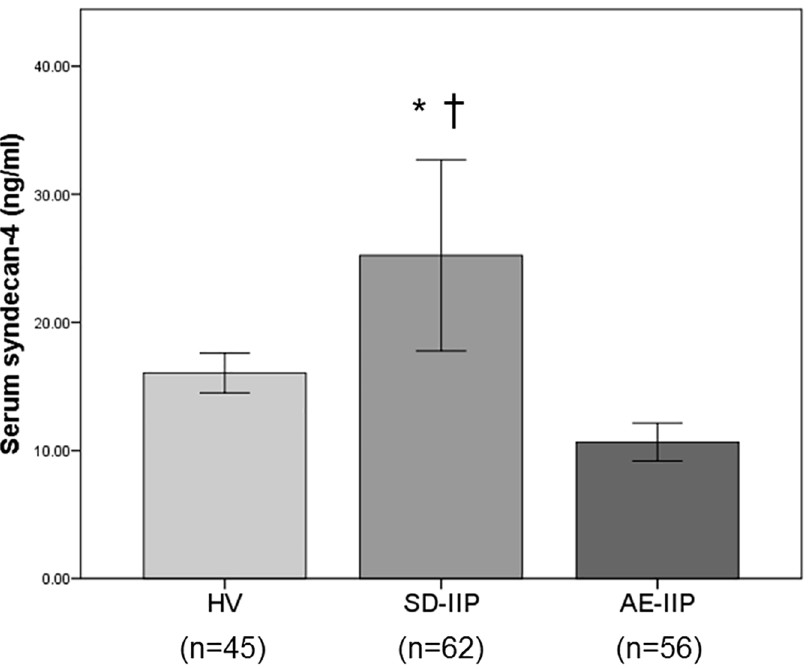
Fig 1. Comparison of serum syndecan-4 levels in healthy volunteers and in patients with SD-IIP and AE-IIP. Serum syndecan-4 levels were significantly higherin the SD-IIP group than in the HV and AE-IIP groups. Serum syndecan-4levels did not differ betweenthe HV and AE-IIP groups. HV: healthy volunteer group, SD-IIP: patient group with stable idiopathicinterstitial pneumonia, AE-IIP: patient group with acute exacerbation of idiopathic interstitial pneumonia. ANOVA with Tukey HSD was used for statistical analysis. * : p < 0.05 vs HV. †: p < 0.001 vs AE-IIP. Data are expressedas means ± the standard error of the mean (SEM).